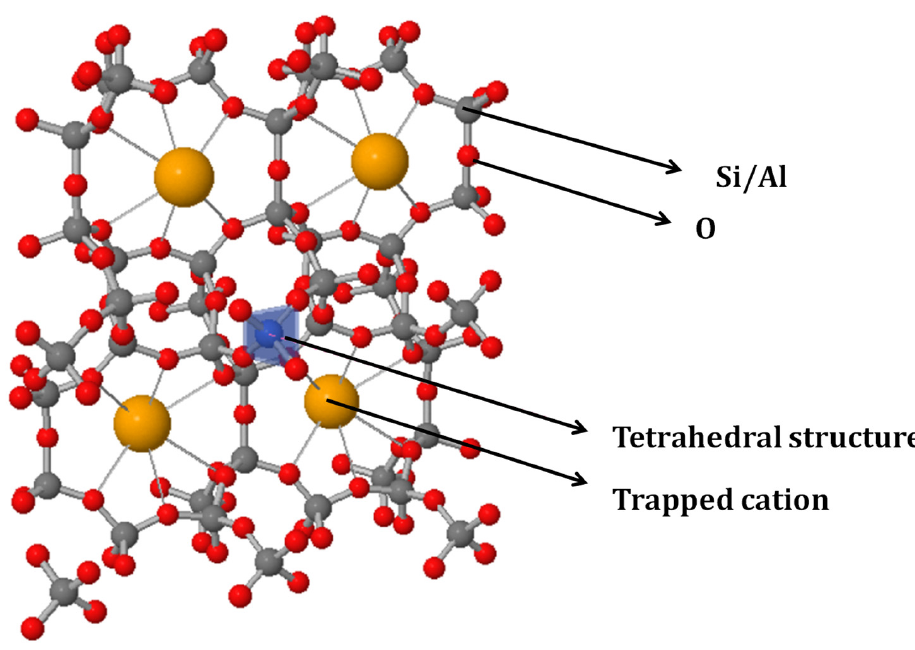
Figure 4. The Tetrahedral Framework of Clinoptilolite Zeolite. Modified from IZA [43]. The general empirical formula that refers to a zeolite structure is M 2n O. Al 2 O 3 . xSiO 2 . yH 2 O. M refers to any alkali or alkaline earth cation; the valence of the cation is indicated by n, x ranges between 2 and 10, and y ranges between 2 and 7, with structural cations comprising Si 2+ , Al 3+ and Fe 3+ , and exchangeable cations K + , Na + and Ca 2+ [44].